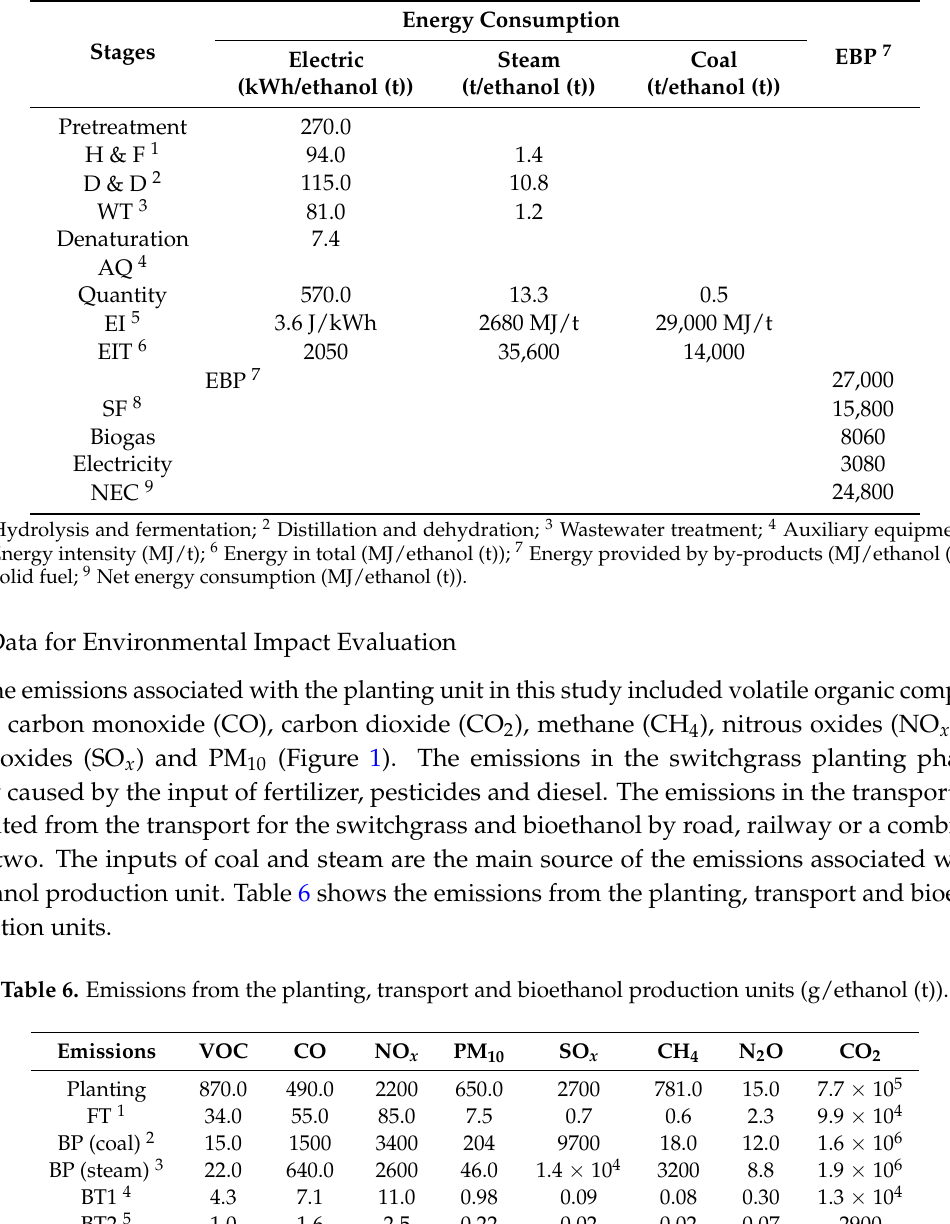
Table 5. Energy consumption in the bioethanol production unit.